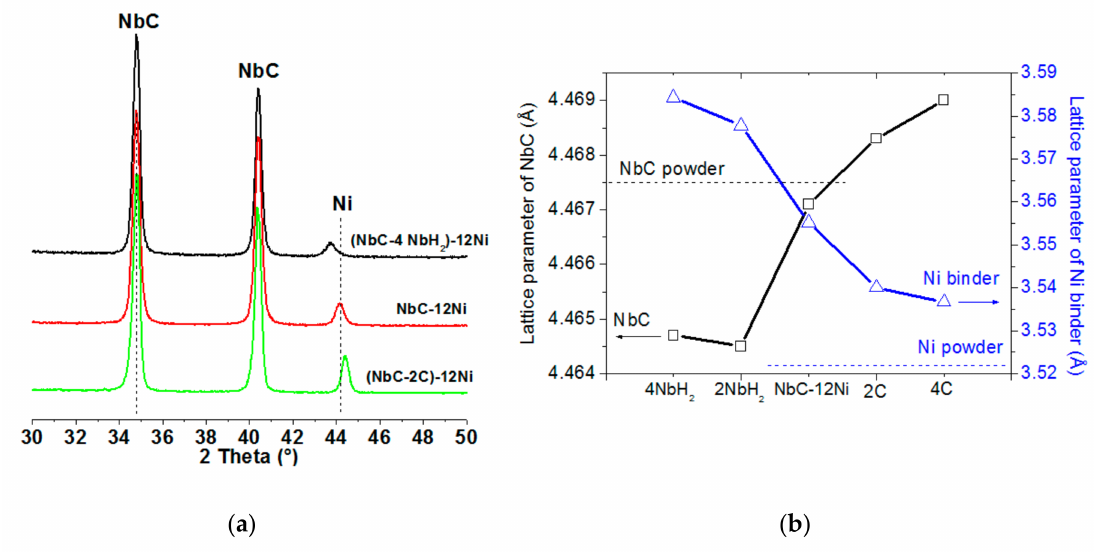
Figure 3. X-ray diffractometer (XRD) patterns of the NbC-12 vol % Ni cermets with different C content ( a ) and influence of the C content on the lattice parameter of NbC and Ni binder phases ( b